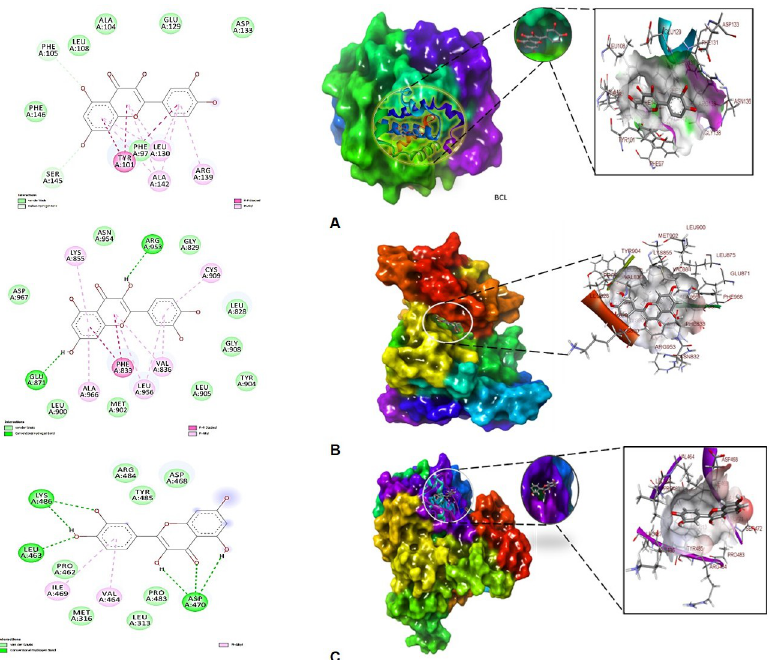
Fig 2. Best docked pose of quercetin with (A) BCL-2, (B) JAK2 and (C) Cytochrome P450 Cyp2E1 displaying 2D interaction plot on the left panel. Green dashed lines indicating the conventional hydrogen bonds and residues embedded in light green sphere indicating to involve in hydrophobic interactions. On the center panel, surface view of (A) BCL-2, (B) JAK2 and (C) Cytochrome P450 Cyp2E1 displaying binding cavity of quercetin and right panel displaying the zoomed out binding pocket having amino acid residues at 3 Å surrounding the quercetin